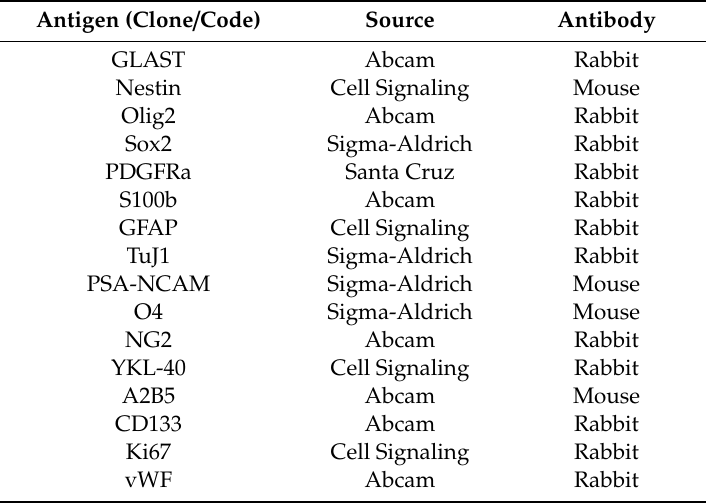
Table 3. Primary antibodies